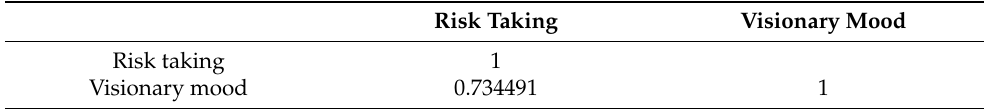
Table 10. The correlation matrix of the measures of strategic thinking. Risk Taking Visionary Mood Risk taking 1 Visionary mood 0.734491